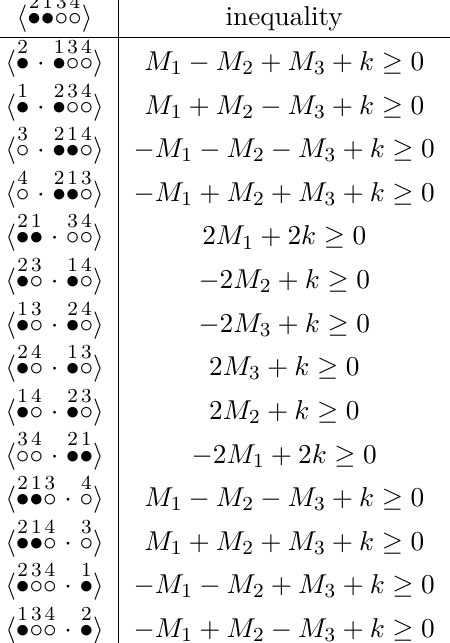
Table 3 . Inequalities found by comparing the reference rank with various ranks (denoted by · ) in various brane configurations obtained from the HW